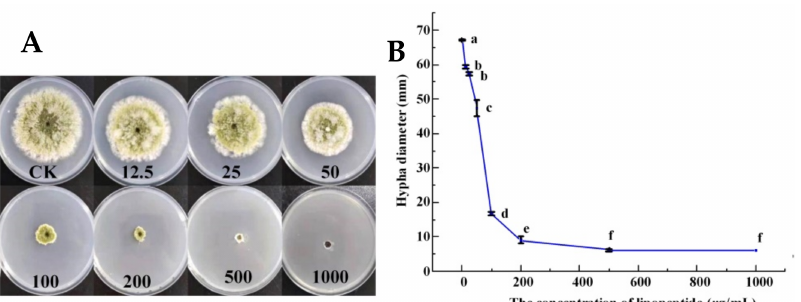
Figure 4. The changes in growth diameter and inhibition rate of A. flavus under the effect of the control group (SDW) and test group (12.5–1000 µ g/mL, LPs) were treated, respectively. ( A ) Colony morphology of A. flavus grown on media containing different concentrations of LPs. ( B ) Colony diameter of A. flavus after treating with LPs. Vertical bars represent standard errors of the mean. Different letters indicated significant differences (LSD test, p <